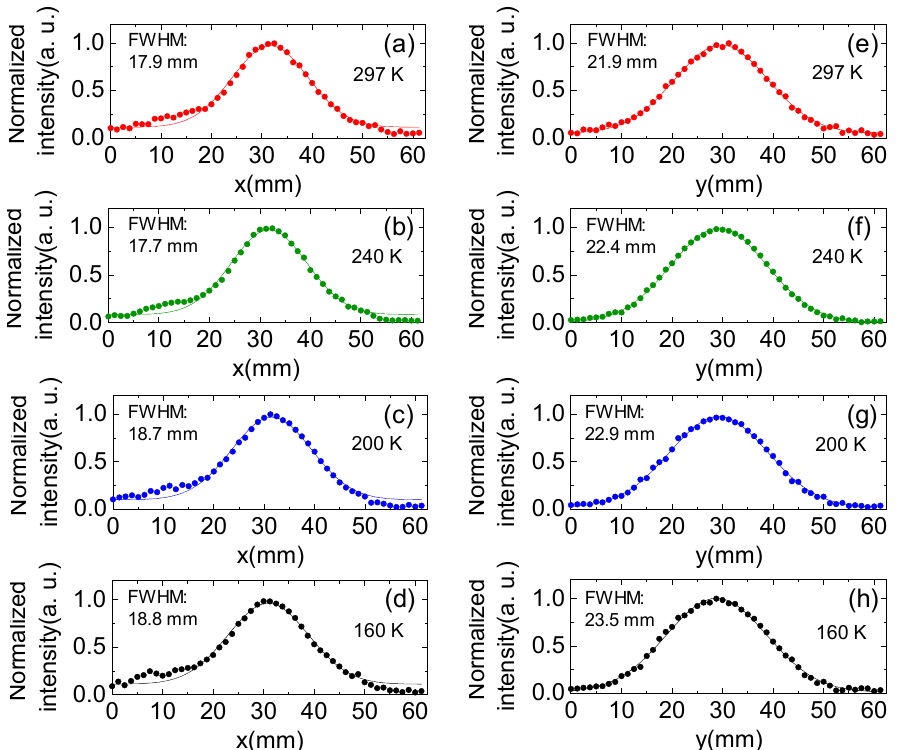
Figure 3. Far-field profiles from THz NL-QCL at: ( a ) 297 K, ( b ) 240 K, ( c ) 200 K and ( d ) 160 K.